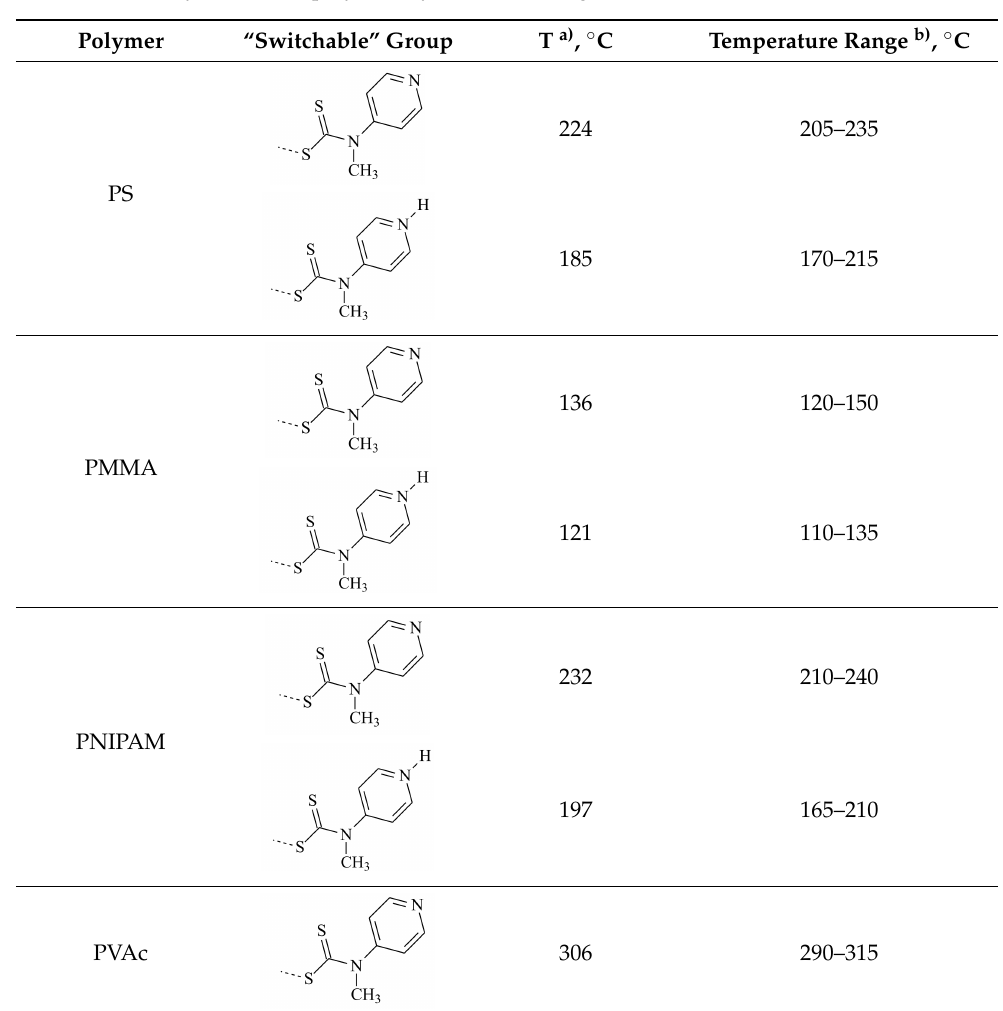
Table 5. Thermolysis data for polymers synthesized using “switchable” dithiocarbamates